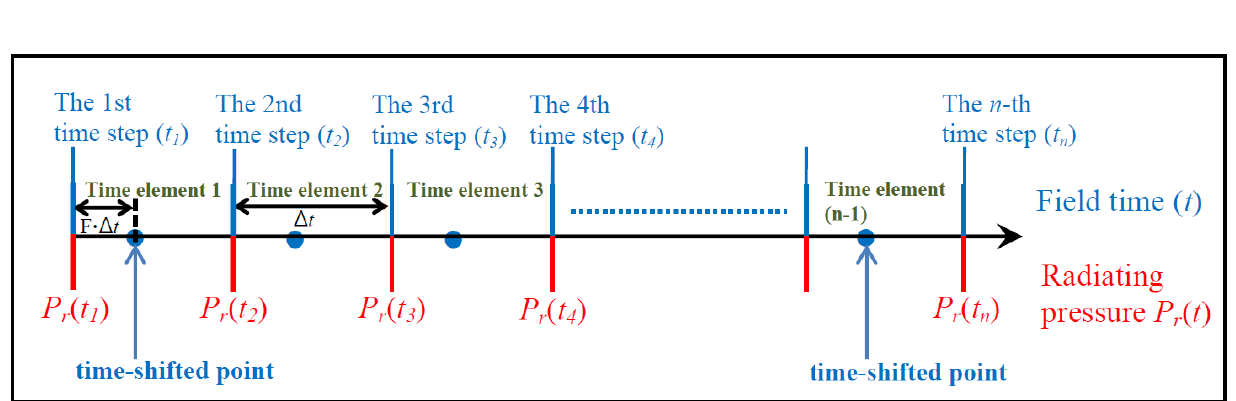
Figure 2. The illustration of the boundary element method with a relaxation technique.